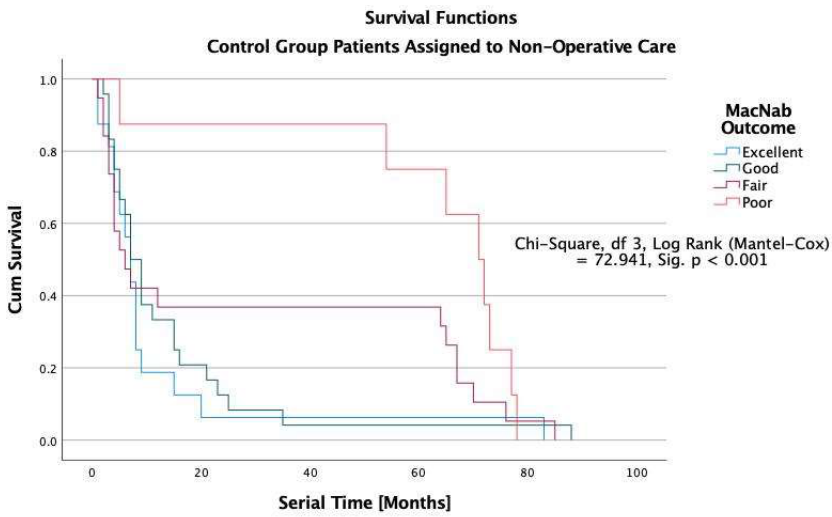
Figure 5. The estimated median (50% percentile) survival times for each of the three surgery types by Macnab outcome criteria are listed in Table 4. The estimated median (50% percentile) durability (survival) among all 412 study patients was 38 months with a standard error of 1.864, a lower boundary of 34.347, and an upper boundary of 41.653. Patients were censored if they required additional treatment after their index operation or if their outcome was not known at their final follow-up. Control patients were censored if they failed conservative care and crossed over into one of the surgical treatment groups or required interventional pain management care with spinal injections. Control group patients were recruited from patients who, during their first encounter, declined any surgical or interventional care with spinal injections and were treated with medical pain management and active physical rehabilitation programs. Of the control patients, the crossover rate into interventional and surgical care was 40.3% and 37.2%, respectively. Only 15 of the 67 (22.4%) control patients continued with conservative care until final follow-up; all of which had fair and poor functional Macnab outcomes, thus, explaining the short overall survival time in control patients of only eight months with a standard error of 0.942, a lower boundary of 6.154 and an upper boundary of 9.846 months.